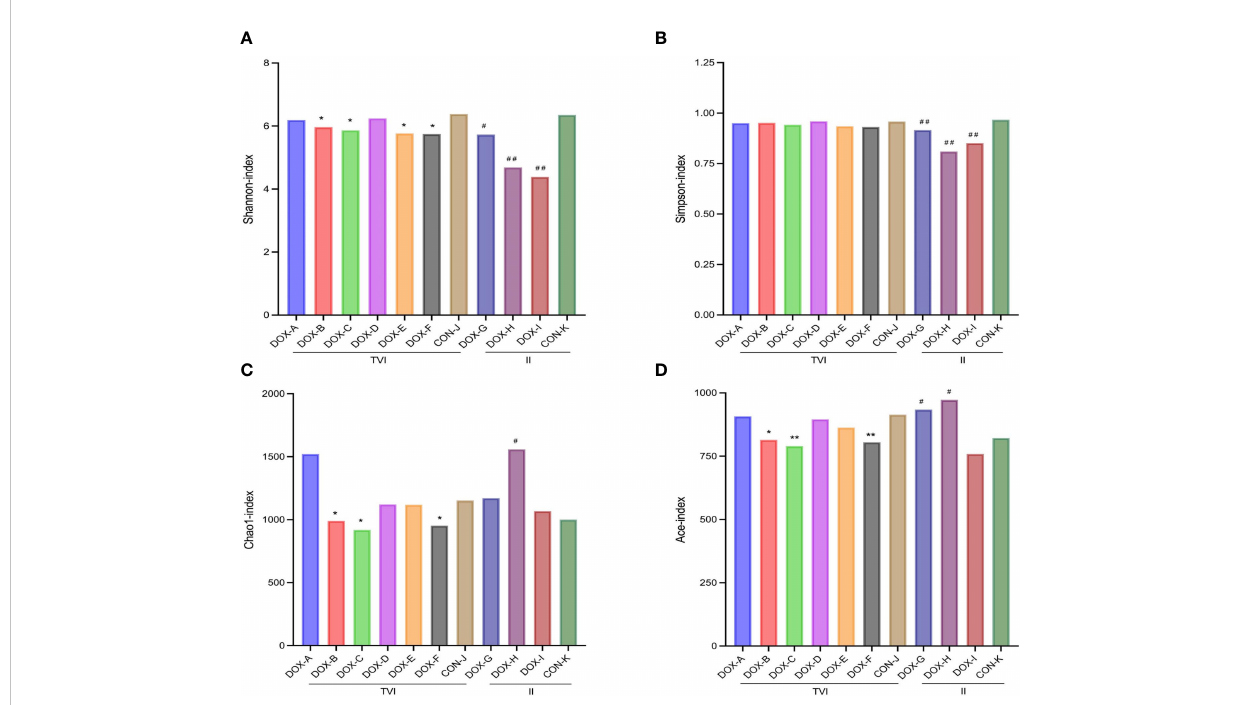
FIGURE 6 Alpha Diversity. (A – D) Shannon,Simpson,Chao1and ACE index. CON, control; DOX, doxorubicin; OTU, operational taxonomic unit; TVI,tail vein injection; II, intraperitoneal injection. * P < 0.05, ** P < 0.01 vs. CON-J; # P < 0.05, ## P < 0.01 vs.